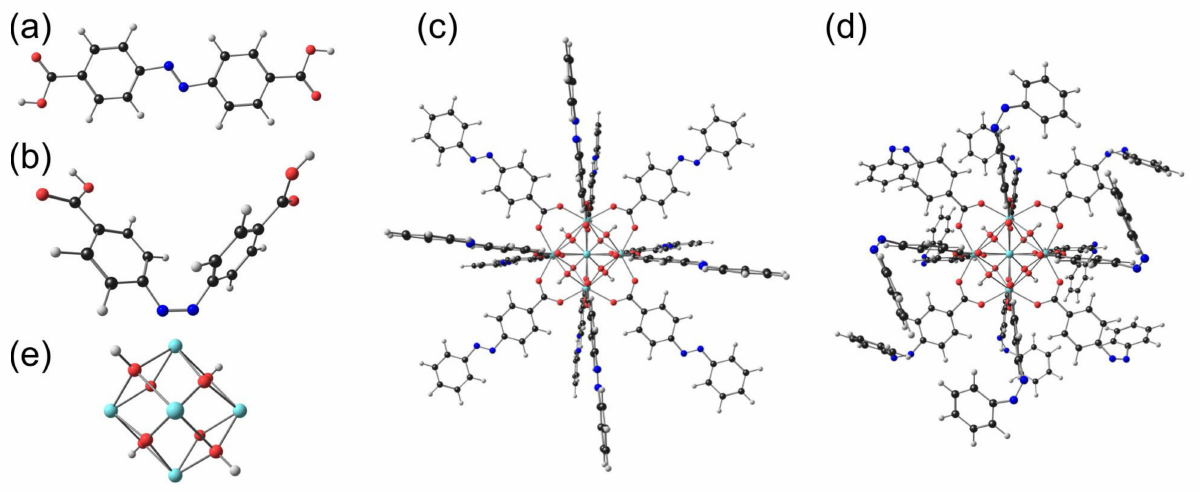
Figure 5. B3LYP gas phase optimised ( a ) trans and ( b ) cis AZB(COOH) 2 . A model molecule of Zr-AZB: ( c ) trans model-Zr-AZB and ( d ) cis model-Zr-AZB. For simplification, the terminal COOH groups in the singly bound ligands were replaced by H. ( e ) The central Zr 6 H 4 O 8 unit of the Zr-AZB MOF (enlarged).